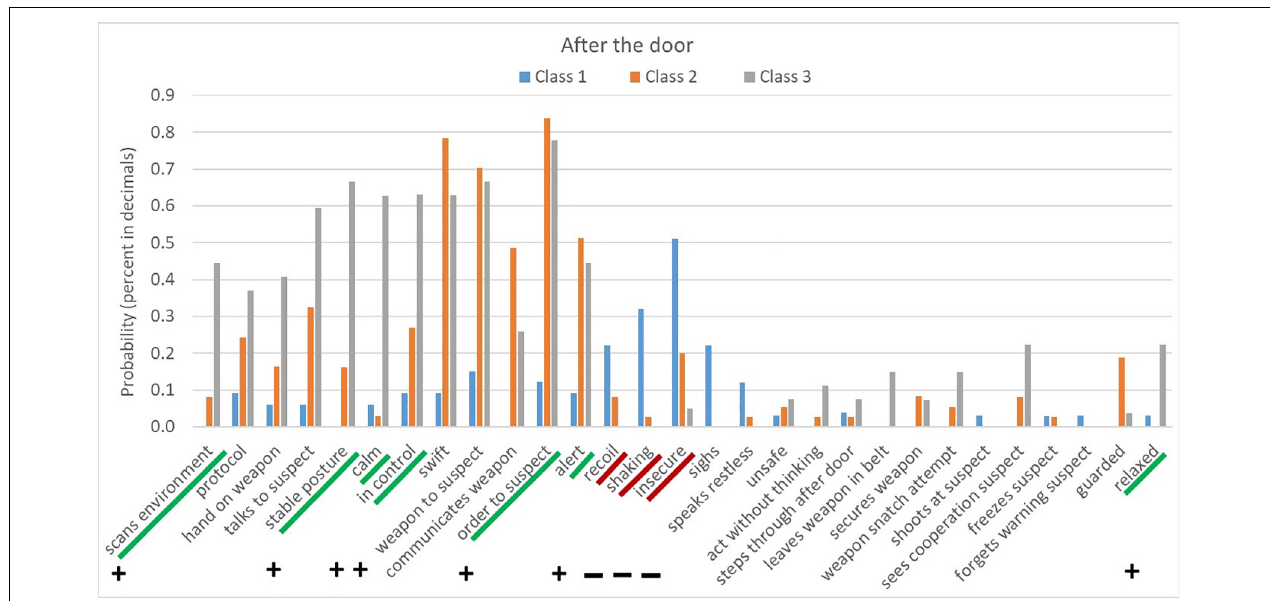
FIGURE 2 | The expected probabilities of the behaviors occurring in each of the three latent classes during the “after the door” phase. The figure also shows which behaviors are positively (underlined in green with plus sign) and negatively (underlined in red with minus sign) associated with psychological competence (see step 9). For behaviors that are not underlined no significant difference was found in psychological competence between the group that displayed the behavior and the group that did